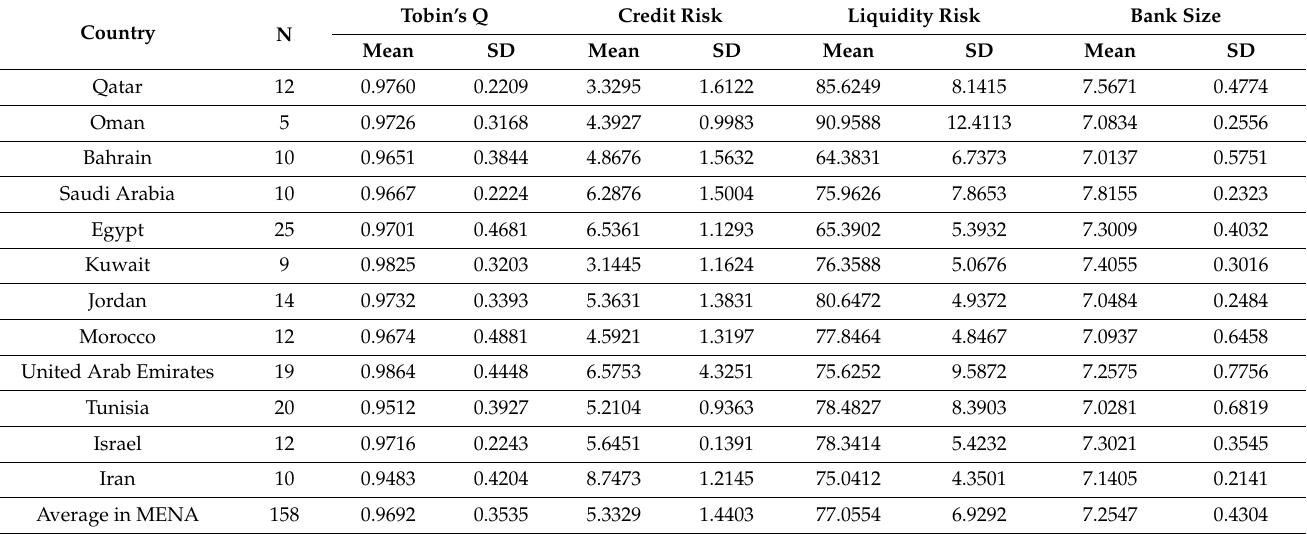
Table 3. Financial Indicators of the Banking Sector in the MENA Region During the Pandemic.